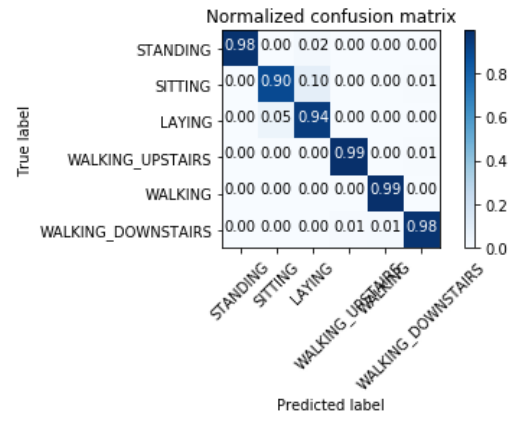
Figure 13. 100 experiments conducted, 70 times our classifiers show best results plotted better accuracy